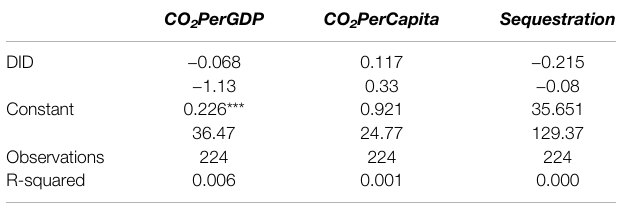
TABLE 11 | A summarization of NRC on low-carbon transition in four